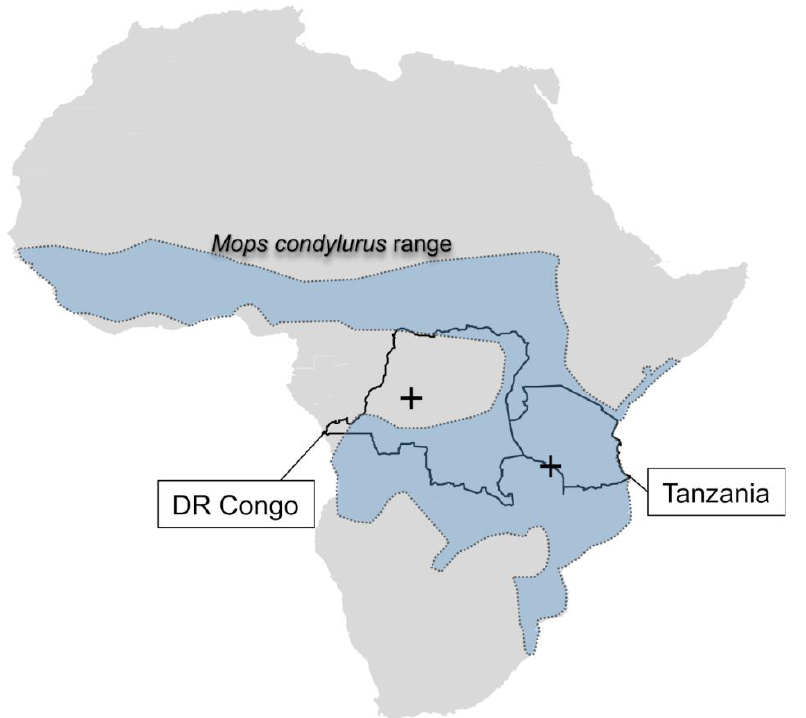
Figure 3. Finding places of bat-borne Kiwira hantavirus in Africa. Detection sites in Mbeya Region (Tanzania) and Salonga National Park (DRC) are marked by crosses. The approximate geographical range of the host species Mops condylurus is marked by a dashed line and blue shading (adapted from www.iucnredlist.org, accessed on 1 September 2022).